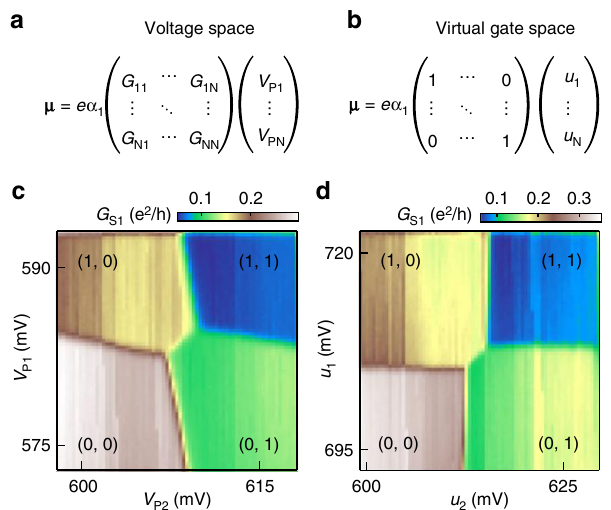
Fig. 2 De fi ning a virtual gate voltage space. The chemical potential of the array expressed in gate voltage space a , and in virtual gate voltage space b . c DQD charge stability diagram for dots 1 and 2, measured as a function of the plunger gate voltages V P1 and V P2 . d Charge stability diagram for the same DQD, but measured as a function of the virtual gate voltages u 1 and u 2